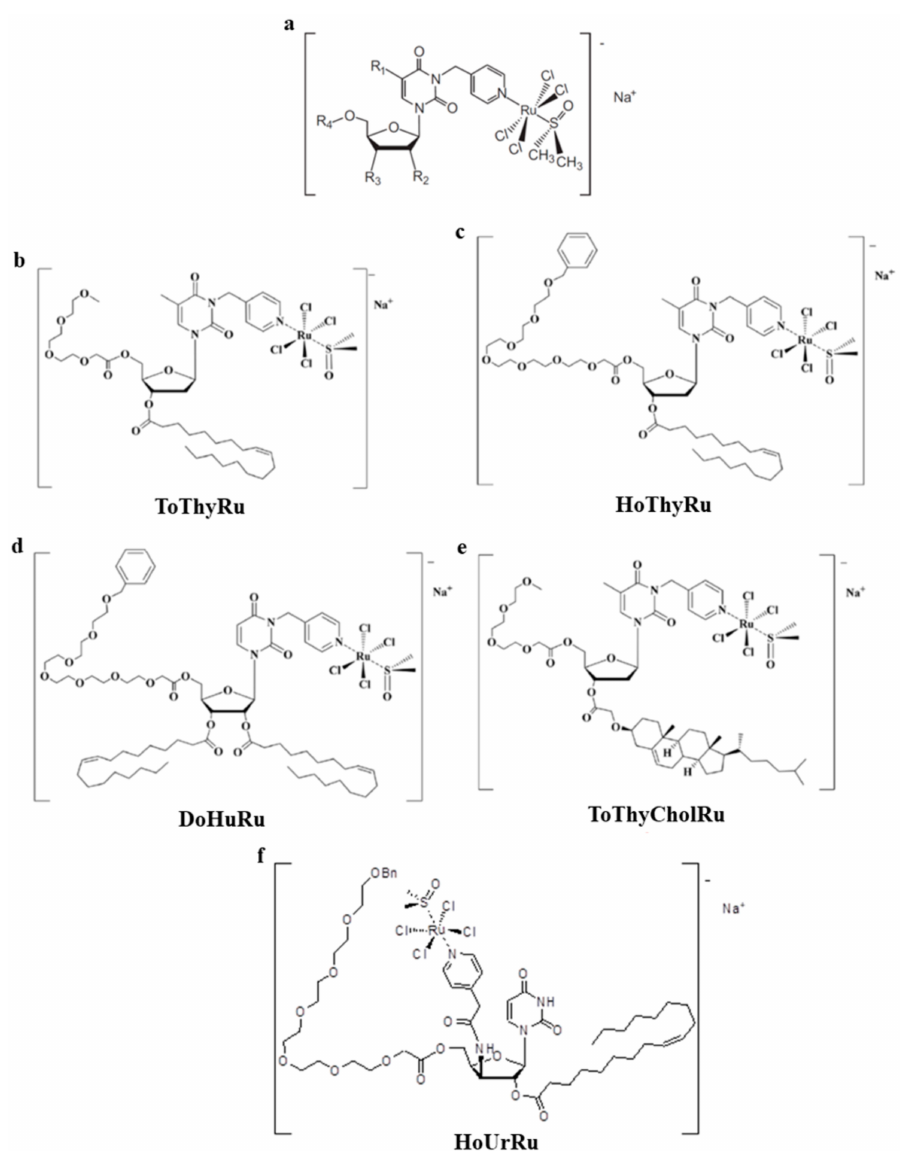
Figure 2. Molecular structures of generic thymidine- or uridine-based nucleolipid Ru(III) complexes ( a ), and of the functional nucleolipid Ru(III) complexes ToThyRu ( b ), HoThyRu ( c ), DoHuRu ( d ), and ToThyCholRu ( e ). HoUrRu ( f ) is a lead compound for a second generation of metal-complexed uridine-based